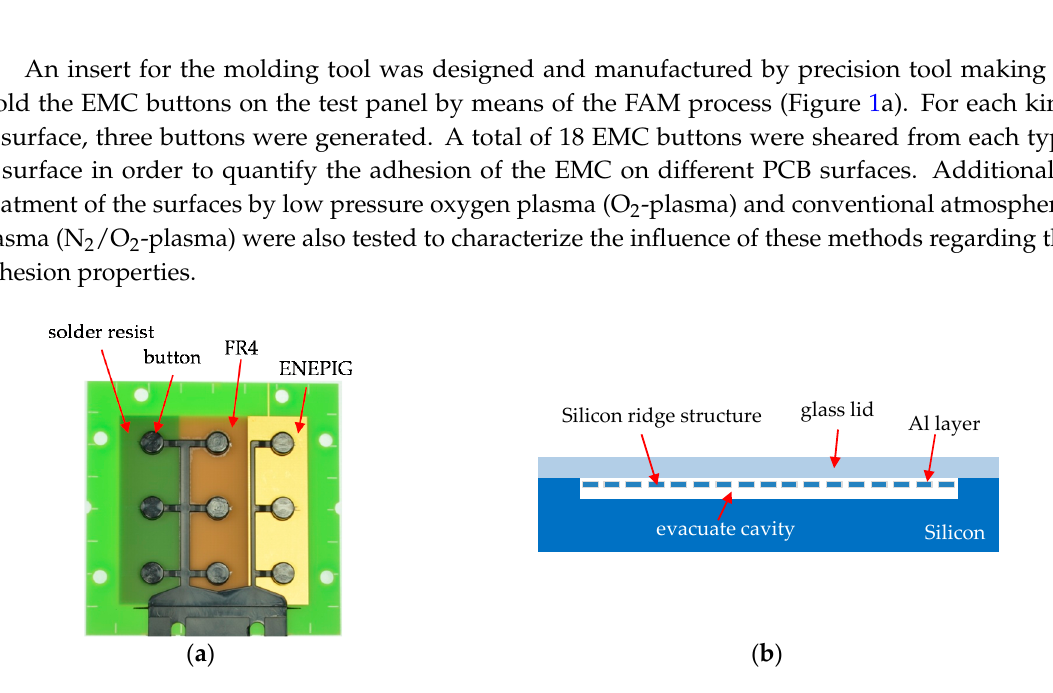
Figure 1. ( a ) Test vehicle for the button shear test to characterize the adhesion strength of the epoxy molding compounds (EMC) on solder resist, FR4 and metal pads with ENEPIG (from left) and ( b ) schemata of the inertia sensor construction.